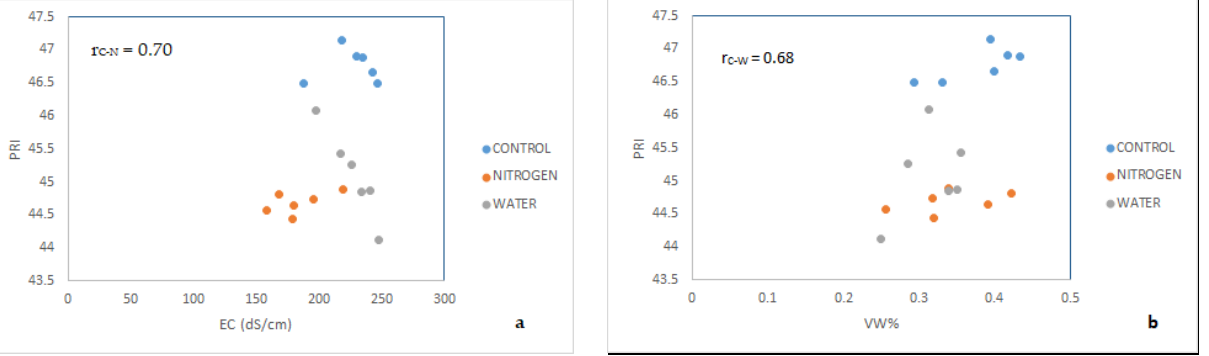
Figure 9. Pearson’s correlation between ( a ) EC (dS/cm) and ( b ) water content weight by volume. Contrary to PRI, NDVI presented less strong correlations with the physiological in- dices of the basil plants. More specifically, a high correlation ( p < 0.05) was observed between NDVI and chlorophyll content (SPAD) under the water and nitrogen stress treat- ments with correlation coefficients of 0.51 and 0.57, respectively (Figure 10a). In addition, a high correlation with a positive correlation coefficient of 0.51 and a negative correlation coefficient of − 0.62 was found between NDVI and EC for both stress treatments with a p -value of < 0.05 (Figure 10c). Finally, NDVI showed a moderate correlation with the nitrogen stress treatment with a positive correlation coefficient of 0.44 (Figure